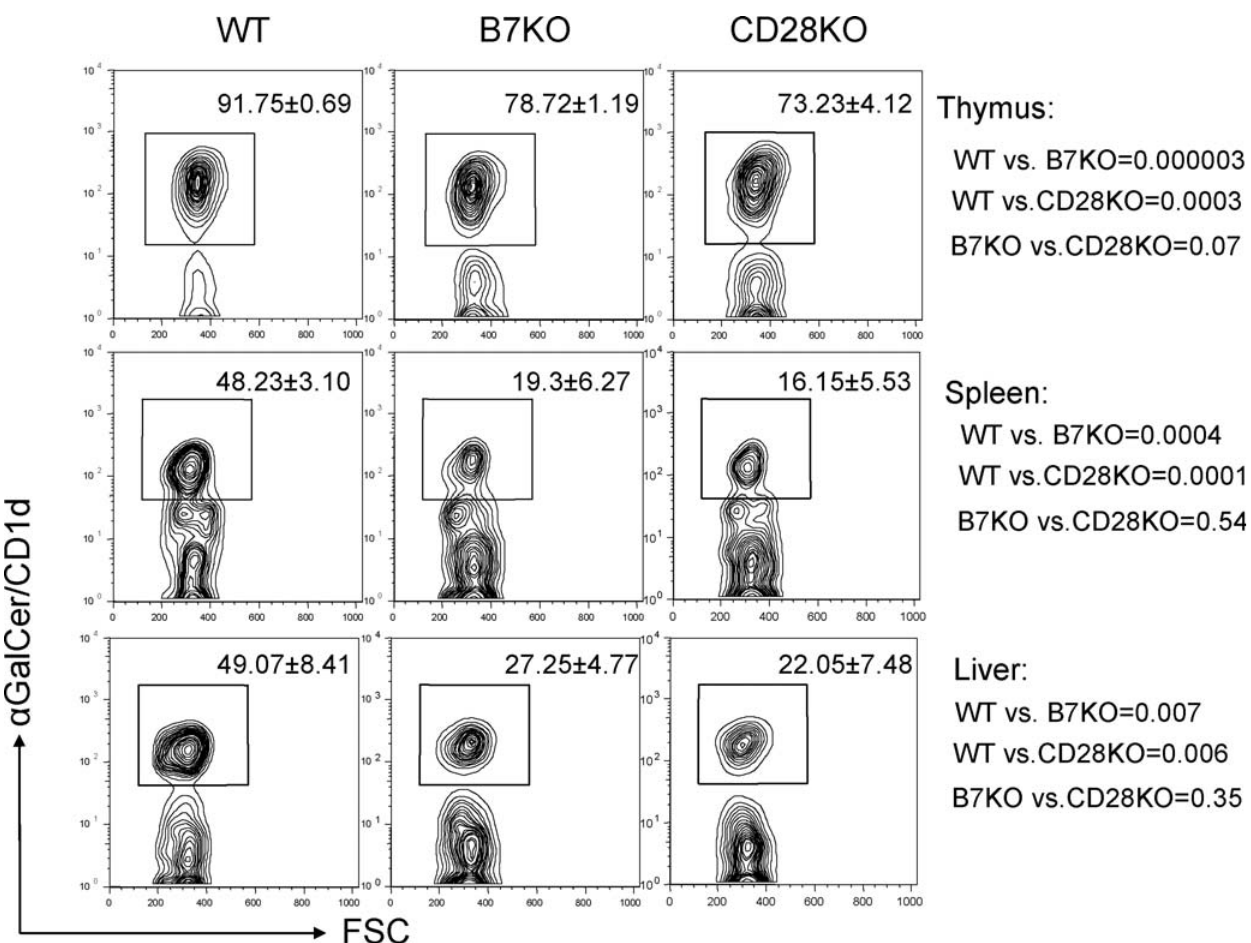
Figure 2. Proportions of iV a 14 NKT cells among TCR b + NK1.1 + cells isolated from the thymus, spleen and liver of WT, B7-1/2 and CD28 deficient mice. Total lymphocytes from the thymus (left), spleen (middle) and liver (right) of 8-week old WT (top), B7-1/2- (center) and CD28- (bottom) deficient mice were stained with TCR b , NK1.1 and a -GalCer/CD1d tetramer. The numbers represent the percentage (Mean 6 SD, n=9) of a - GalCer/CD1d + cells in the TCR b + NK1.1 + population. One representative profile from each group is shown here. The numbers shown on the side of figures are p value between two indicated groups.